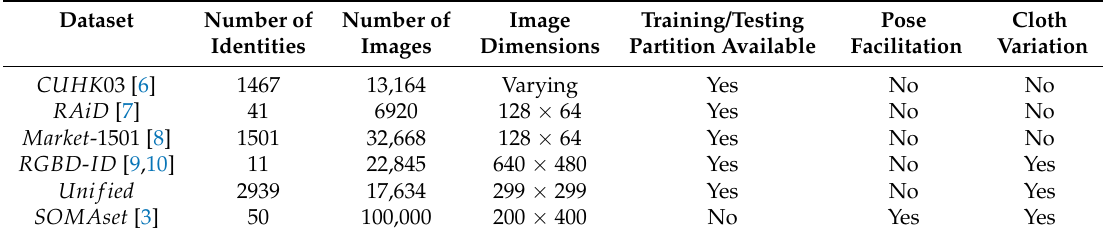
Figure 8. SOMAset dataset example images. Table 1. Sum up of the datasets used and their main